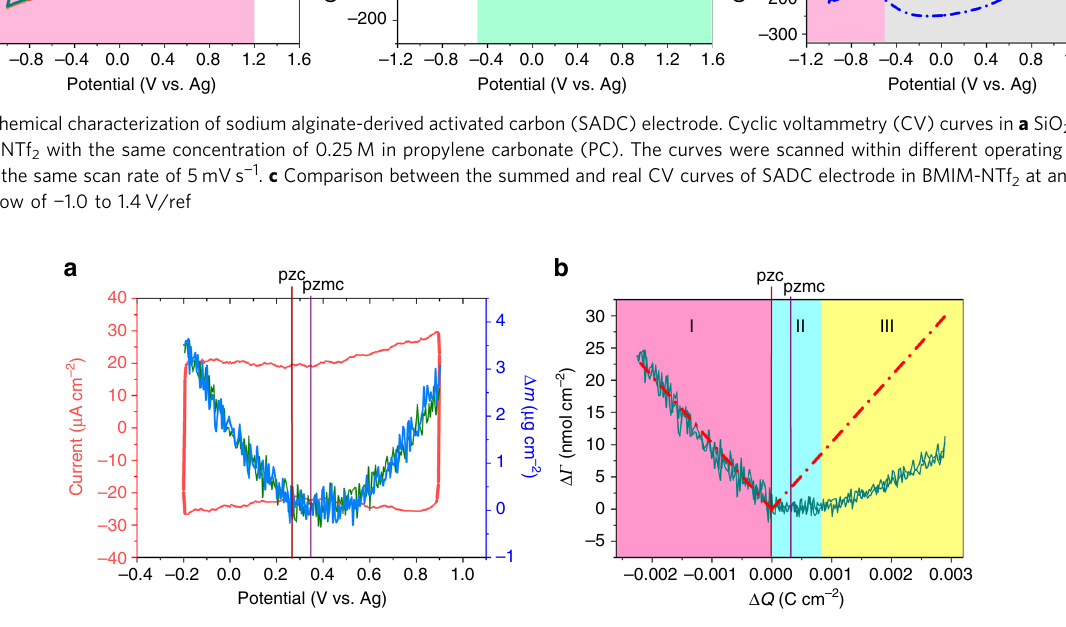
Fig. 6 Electrochemical quartz crystal microbalance (EQCM) analyses of YP-50F-coated quartz electrode in 0.25 M BMIM-NTf 2 /PC electrolyte. a Cyclic voltammetry (CV) curve with a scan rate of 5 mV s − 1 and the corresponding EQCM mass change. b Ion population change as a function of charge density during polarization. Cyan solid line represents the experimental ion population change. Red dashed line is the theoretical ion population change based on perm-selective